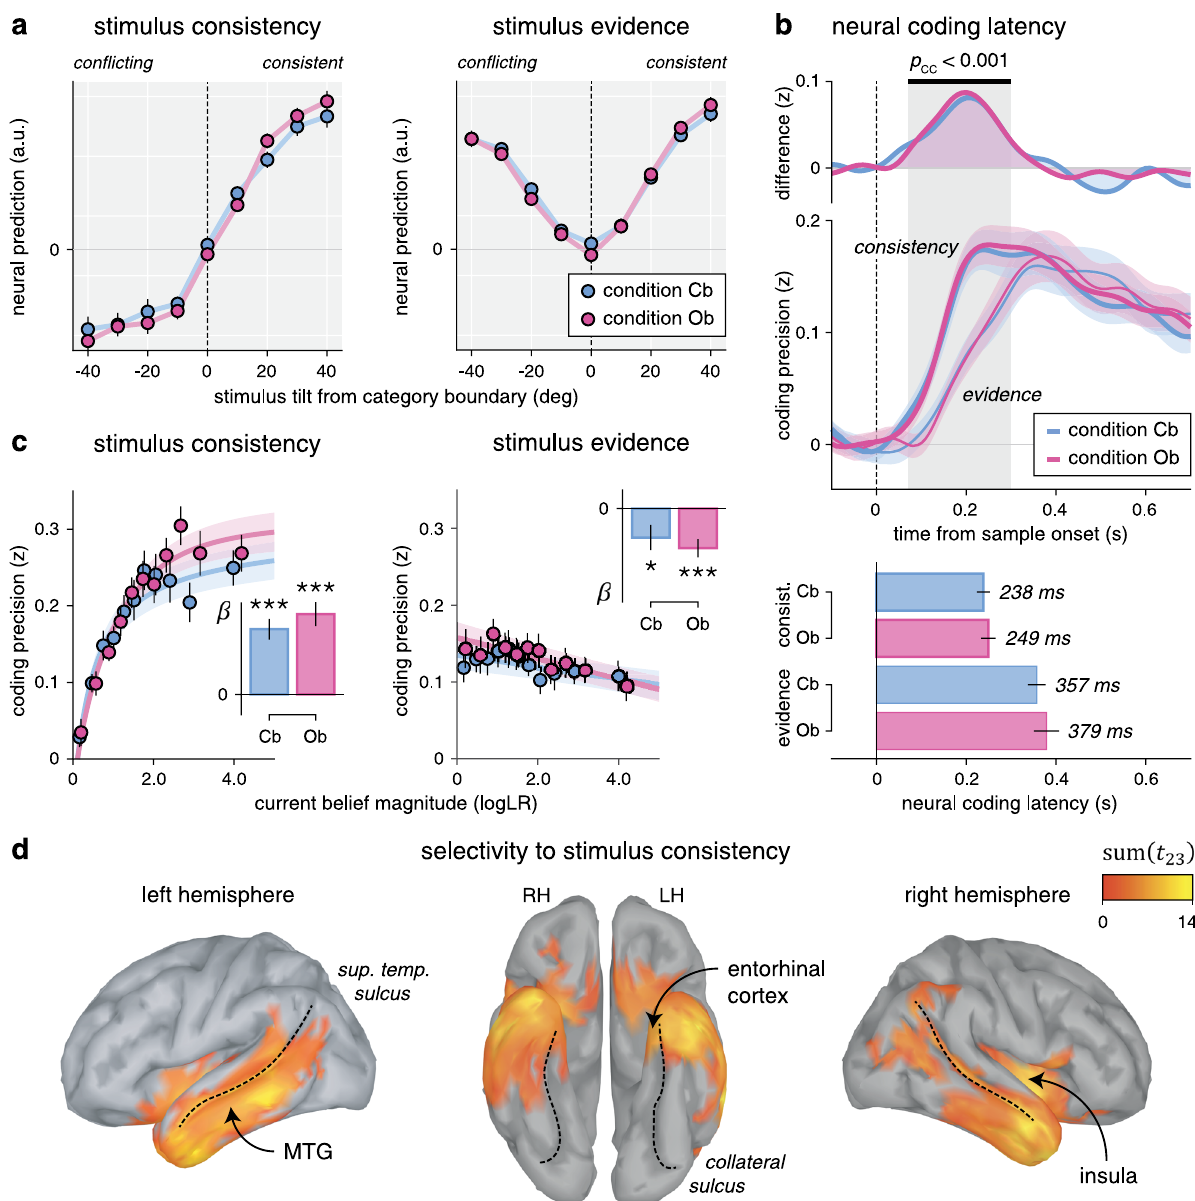
Fig. 7 Neural correlates of absolute and relational coding of evidence. a Neural predictions for stimulus consistency (left) and evidence (right), binned as a function of stimulus tilt from the nearest category boundary. Stimulus tilt is signed in relation to the current belief: a positive tilt indicates a stimulus consistent with the current belief, whereas a negative tilt indicates a stimulus con fl icting with the current belief. Neural predictions of consistency (left) have opposite signs for belief-consistent and belief-con fl icting evidence, whereas neural predictions of evidence strength (right) are independent of the current belief. Dots and error bars indicate means± SEM ( n = 24 participants). b Neural coding latencies for stimulus consistency and stimulus evidence. Top: neural coding time courses (lower panel) and their difference (upper panel). Stimulus consistency (thick lines) shows a faster rise in coding precision than stimulus evidence (thin lines). Lines and shaded error bars indicate means ± SEM. The shaded area indicates a signi fi cant cluster corrected for multiple comparisons at p < 0.001 based on paired two-sided t -tests. Bottom: estimated neural coding latencies. The neural coding of consistency peaks 120 ms earlier than the neural coding of evidence. Bars and error bars indicate jackknifed means ± SEM ( n = 24 participants). c Effect of current belief magnitude on the neural coding of consistency (left) and evidence (right), grouped in equally sized bins. The coding precision of consistency (left), but not evidence (right), scales positively with belief magnitude. Dots and error bars indicate means ± SEM. Lines and shaded error bars show parametric fi ts. Inset: linear regression slope estimates (jackknifed means ± SEM) of coding precision against belief magnitude ( t -test against zero, d.f. = 23, uncorrected for multiple comparisons). d Searchlight-based differences in coding precision between consistency and evidence across the cortical surface (cluster de fi nition p = 0.001, cluster statistic p < 0.001). Thin dotted lines follow the superior temporal sulcus (left and right) and the collateral sulcus (middle). Source data are provided as a Source Data fi